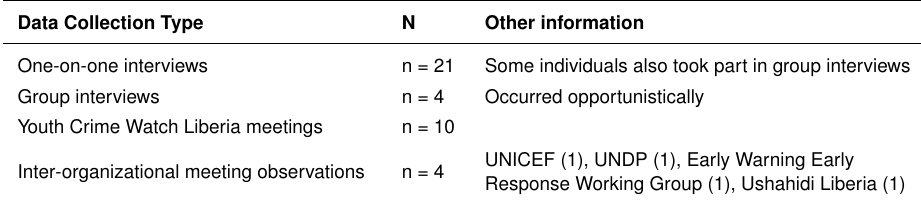
Table 2. Data collection